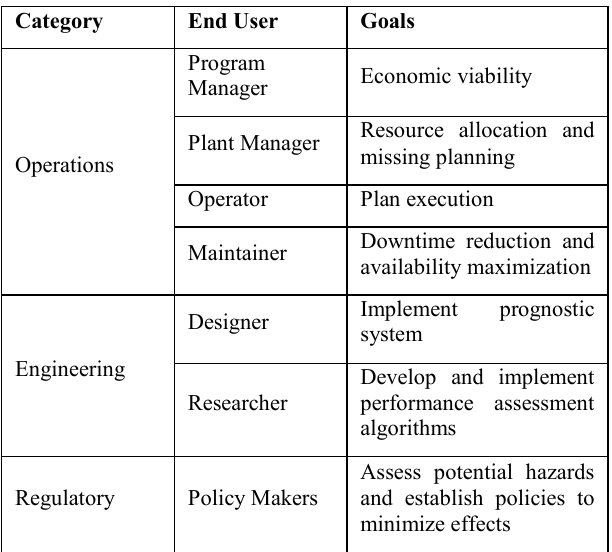
Table 1. Prognostics’ End Users and Accompanying Goals (adapted from Saxena et al.